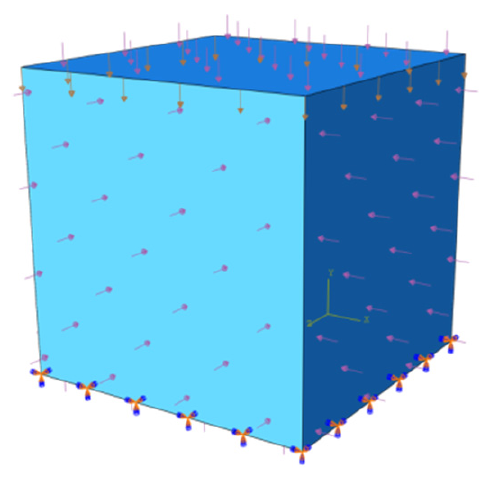
Figure 14. Single unit test and the load condition.